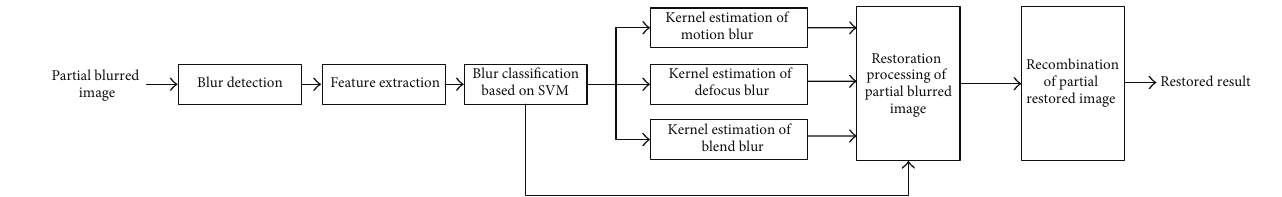
Figure 1: The diagram of restoration